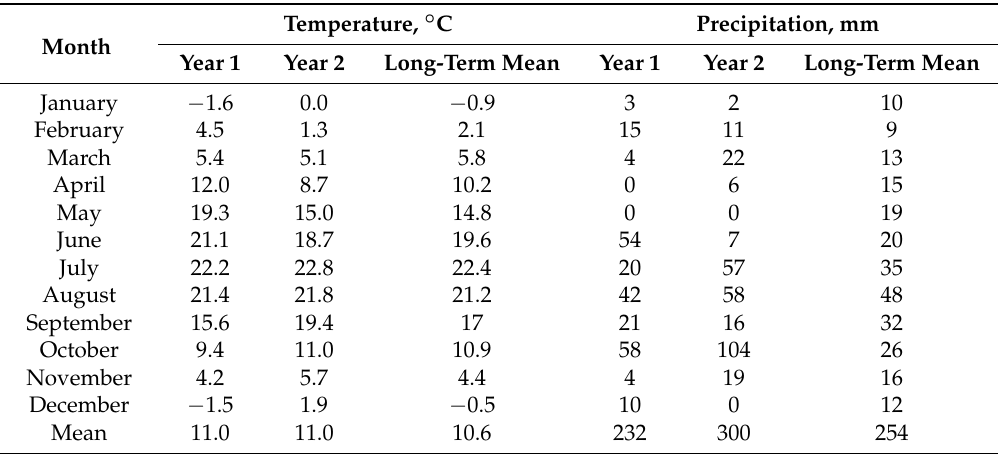
Table 1. Monthly mean air temperatures and total precipitation at Alcalde, New Mexico, USA, from each year of the study period and the long-term (1953–2016) means. Temperature, ◦ C Precipitation,